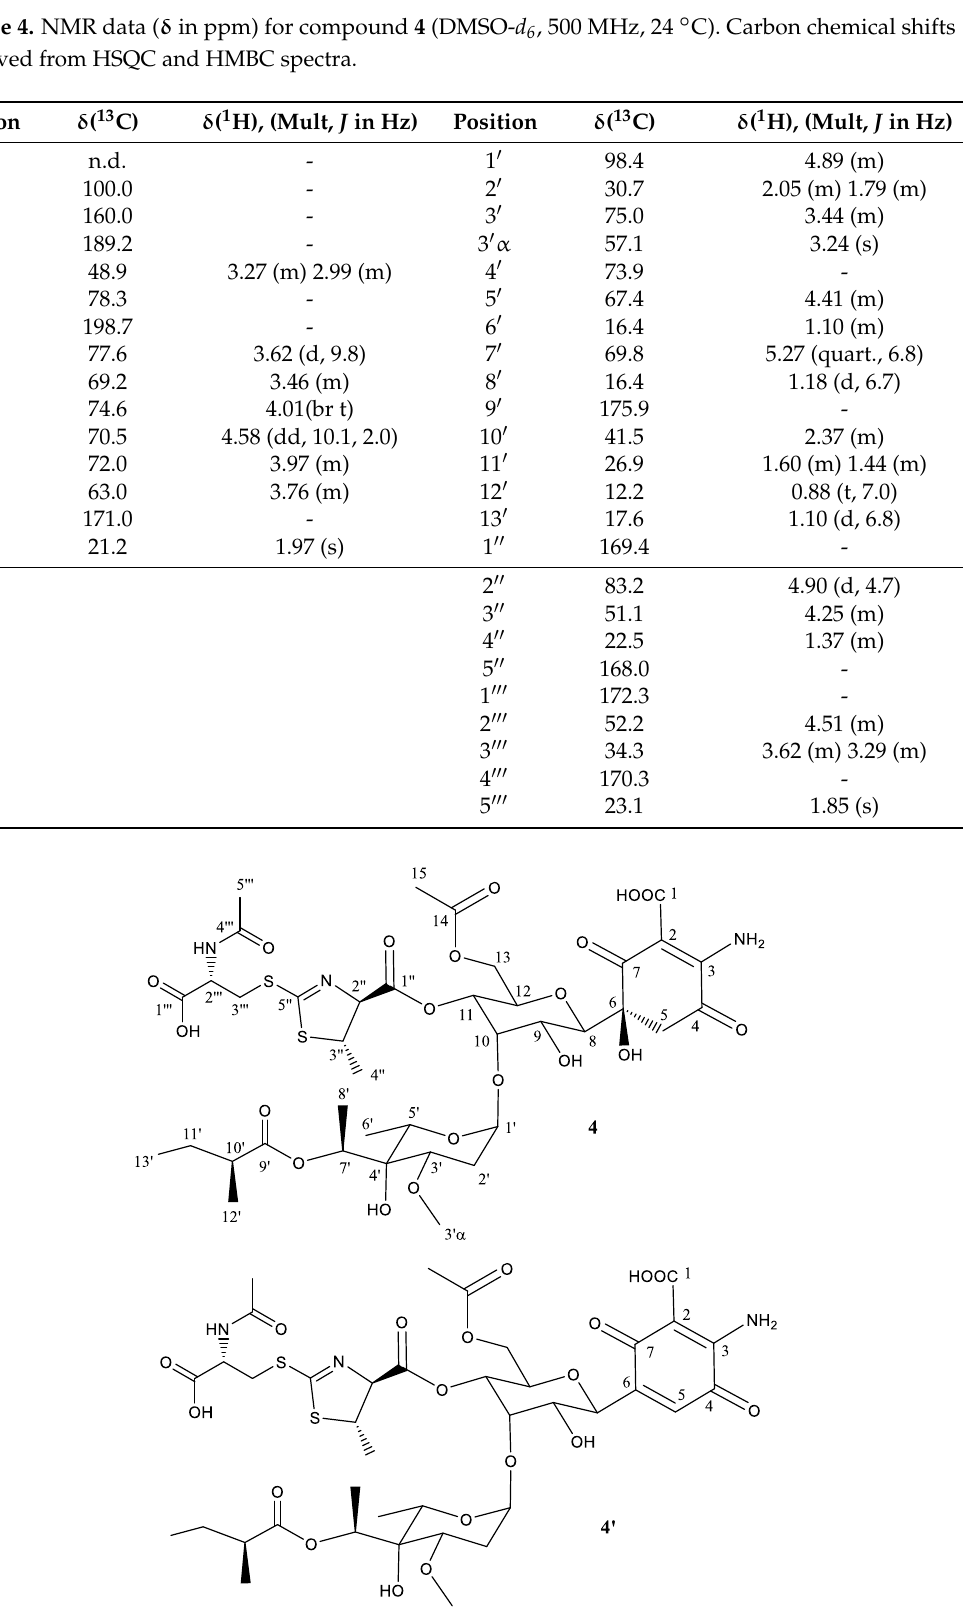
Figure 5. Structure of compound 4 deduced from 1 H- and 13 C-NMR data and proposed structure of secondary product compound 4’ elimination of one molecule of H 2 O.